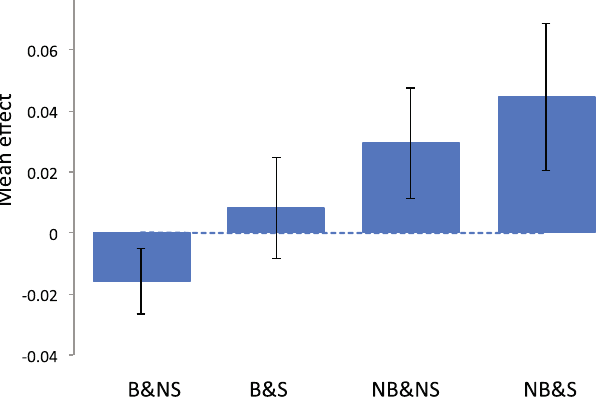
Figure 3. Mean trait value of memory (number of incorrect matches) for each group classified by breastfeeding and maternal smoking status. Vertical bar is 95% confidence interval. The phenotypes of memory were adjusted for birth year, age at recruitment, sex, assessment centre, genotype measurement batch and 15 principal components.